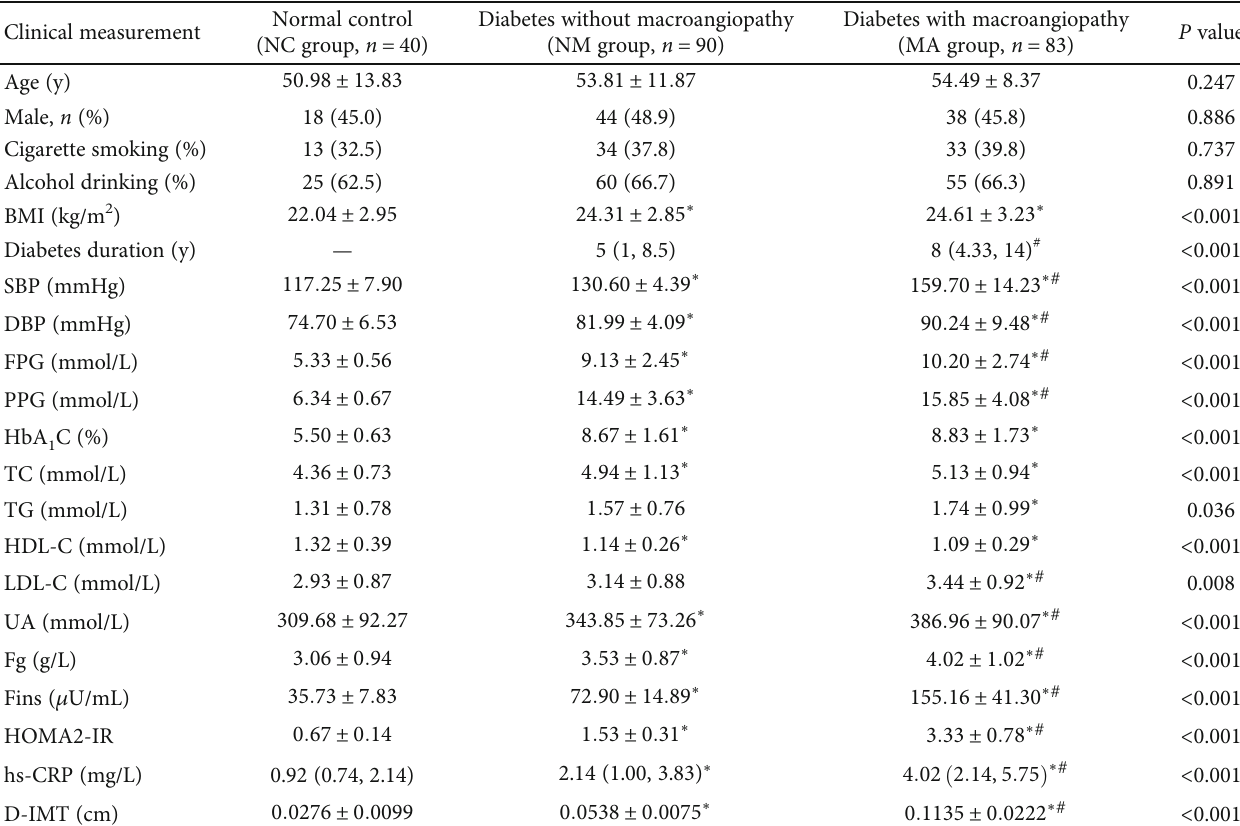
Table 1: Comparison of clinical characteristics among di ff erent